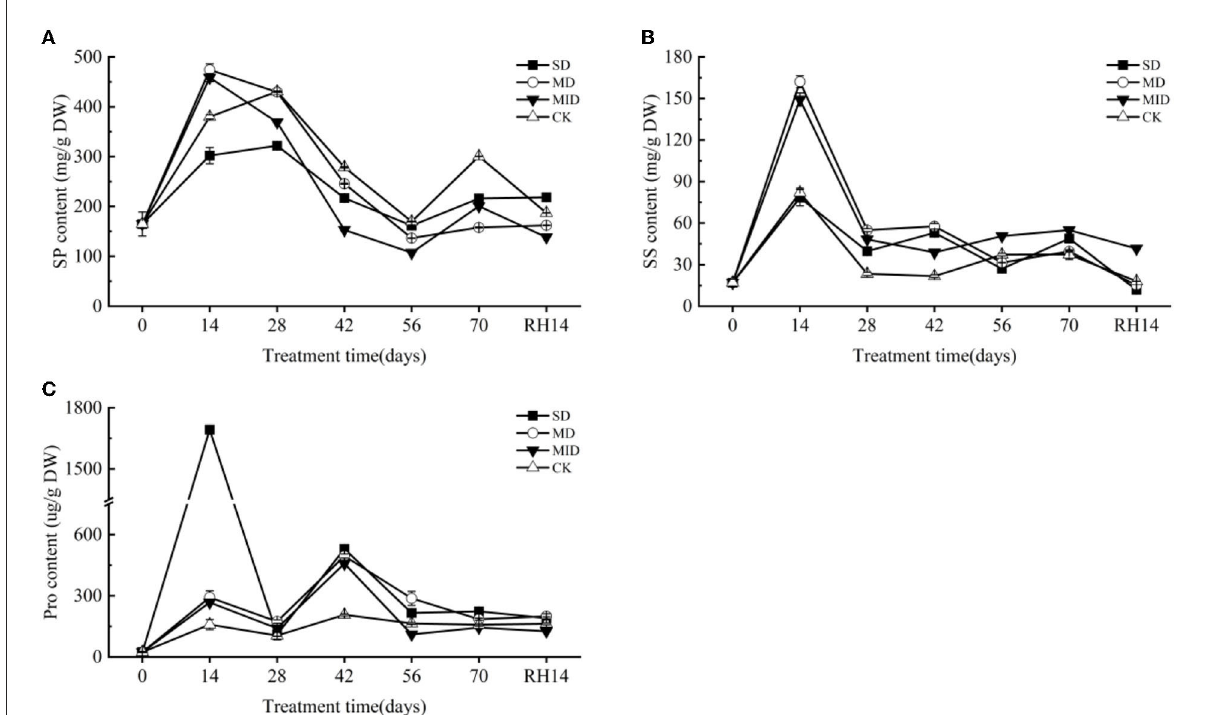
FIGURE8 Osmolytic substances during the drought and rehydration for A. selengensis . Fourteenth day of rehydration (RH, 14 days), soluble protein (SP), soluble sugar (SS), proline (Pro). The severe drought group (SD), the moderate drought group (MD), the mild drought group (MID), the control group (CK). (A) SP of A. selengensis . (B) SS of A. selengensis . (C) Pro of A. selengensis .